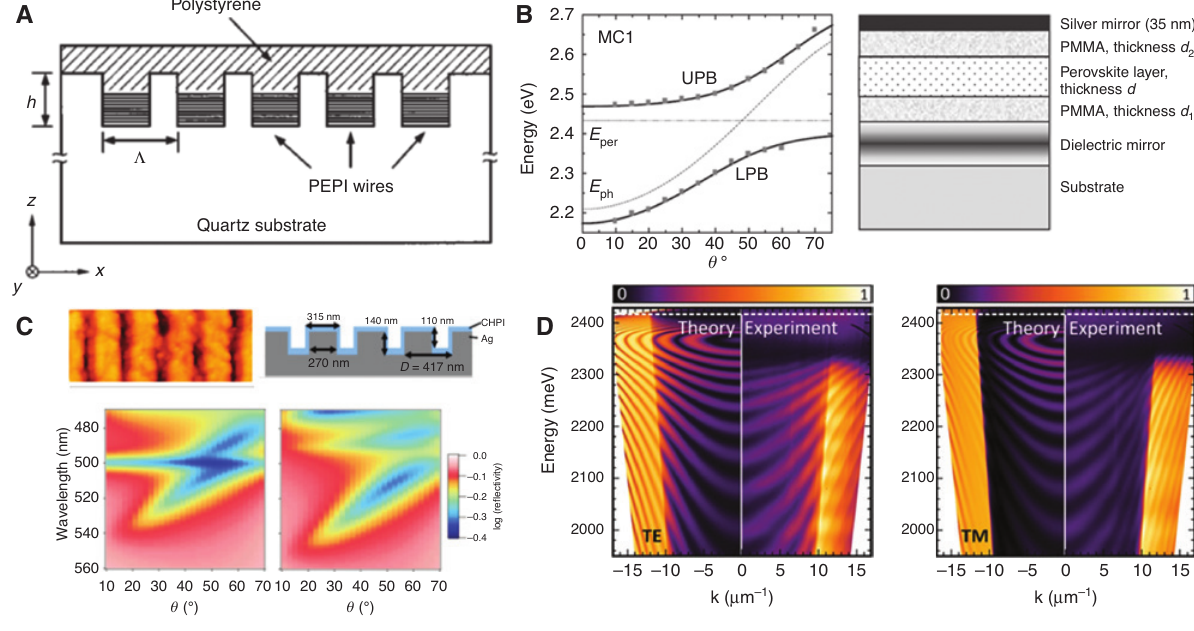
Figure 6: Strong coupling in PVKs. (A) Structure of a DFB microcavity taken from Ref. [68]. (B) Dispersion of the UPB and LPB for PVK microcavity and its schematic structure taken from Ref. [69]. (C) AFM image of the PVK-coated Ag grating, its schematic cross section, and simulated reflection spectra for in-plane (on the left) and out-of-plane (on the right) exciton dipoles taken from Ref. [70]. (D) Exciton-photon coupling in 2D PVK single crystals not embedded in reflective mirror microcavity taken from Ref.